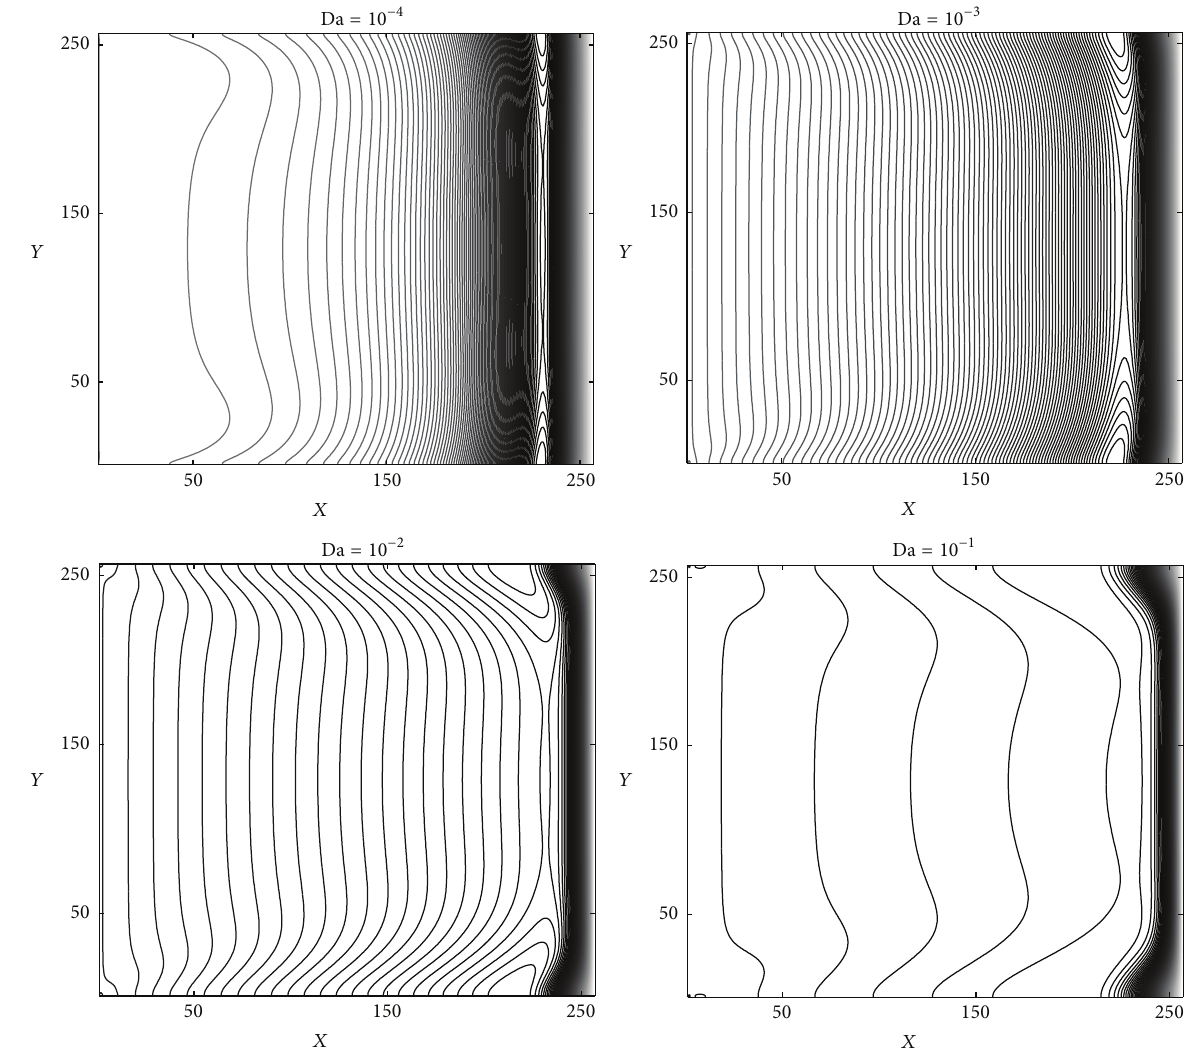
Figure 3: Isothermals for the Darcy numbers: Da = 10 −4 , 10 −3 , 10 −2 , and 10 −1 .